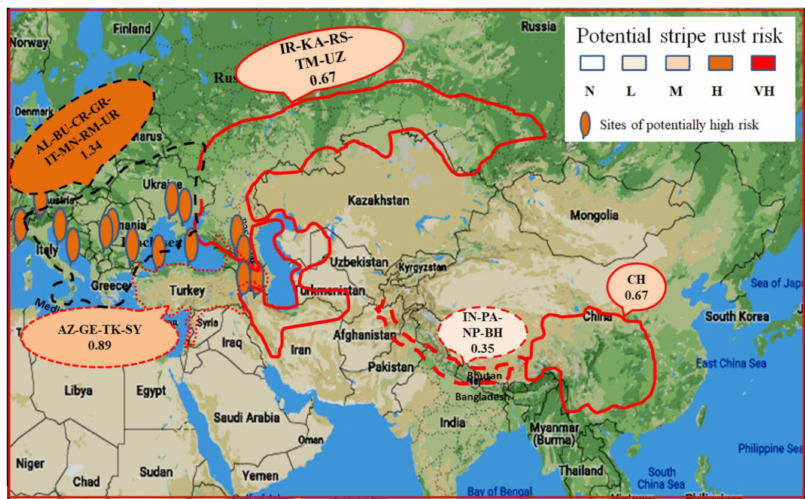
Figure 4. Areas of potential infection risks for the stripe rust pathogen ( Puccinia striiformis f. sp. tritici ) in Asia including China, hilly regions of Indo–Pak–Nepal–Bhutan (IN-PA-NP-BH), Central Asia (IR-KA-RS-TM-UZ), and West Asia surrounding Black Sea and Caspian Sea (GE-AZ-TK). AZ = Azerbaijan, BH = Bhutan, CH = China, IN = India, IR = Iran, KA = Kazakhstan, NP = Nepal, PA = Pakistan, RS = Russia, TM = Turkmenistan, and UZ = Uzbekistan.